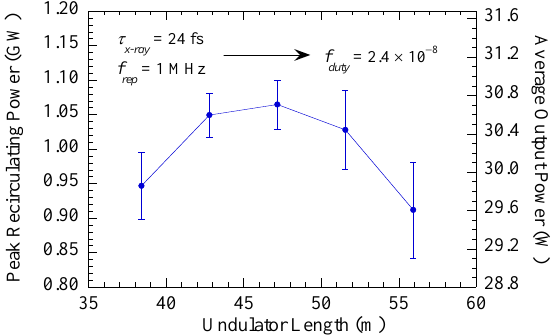
Figure 23. Recirculating output power versus length of the undulator L u for a hole radius of 135 µm. Other simulation parameters as described in the text.